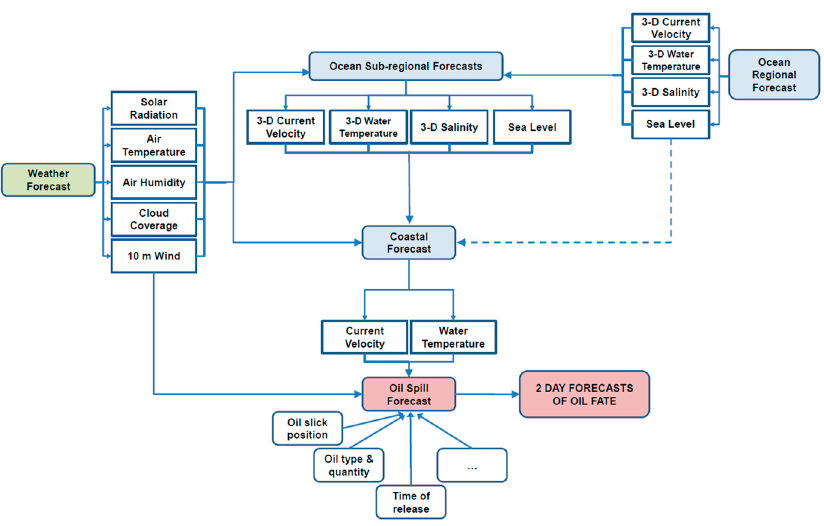
Figure 2. The numerical forecasting chain for coastal circulation and oil dispersion at sea.